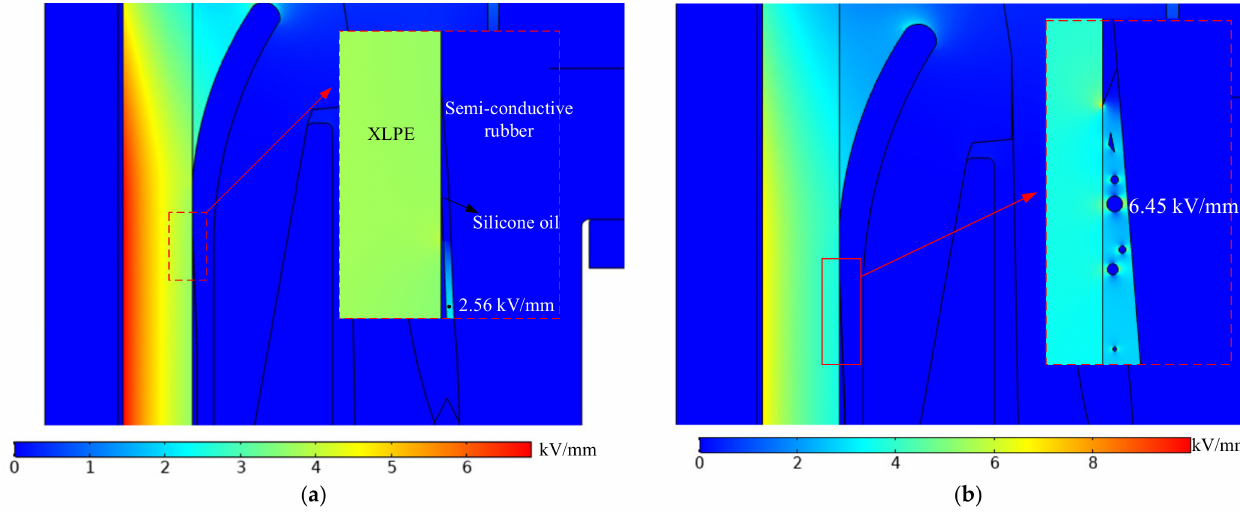
Figure 8. Electric field distortion at the interface in GIS cable terminal: ( a ) without defects, ( b ) with